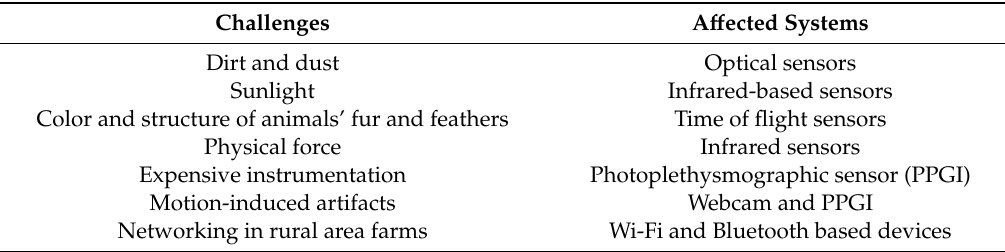
Table 2. Challenging factors in deploying sensor technology for animal